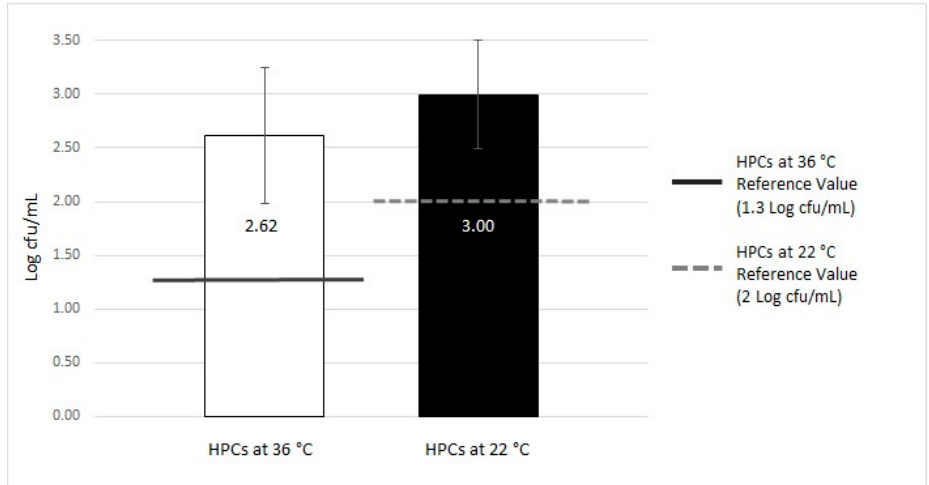
Figure 2. Microbiological contamination of total of samples of MWDs (microfiltered water dispensers): analysis of HPCs (heterotrophic plate counts) at 36 °C and 22 °C analysis.